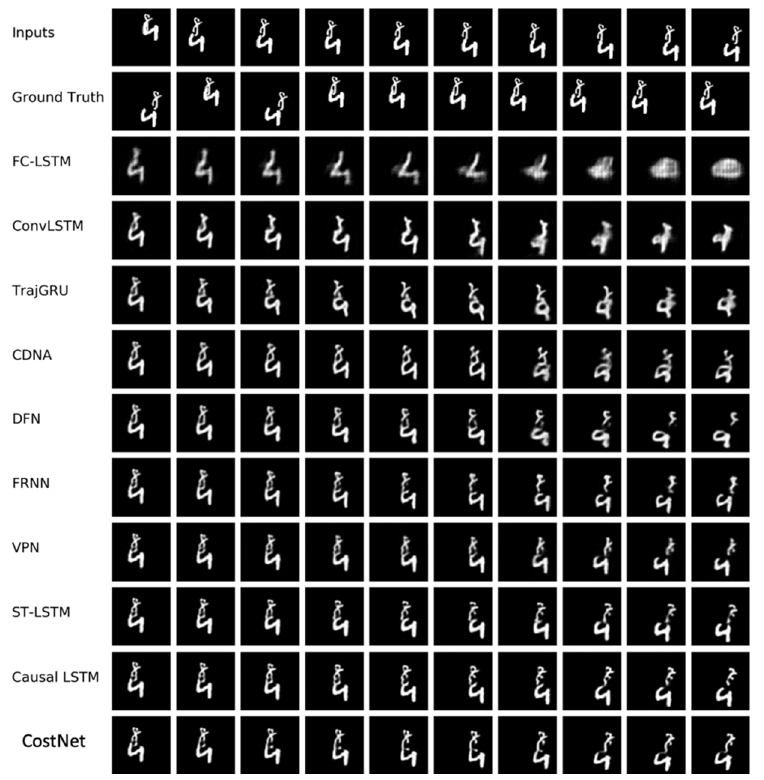
Figure 4. Prediction examples on the Moving MNIST test.